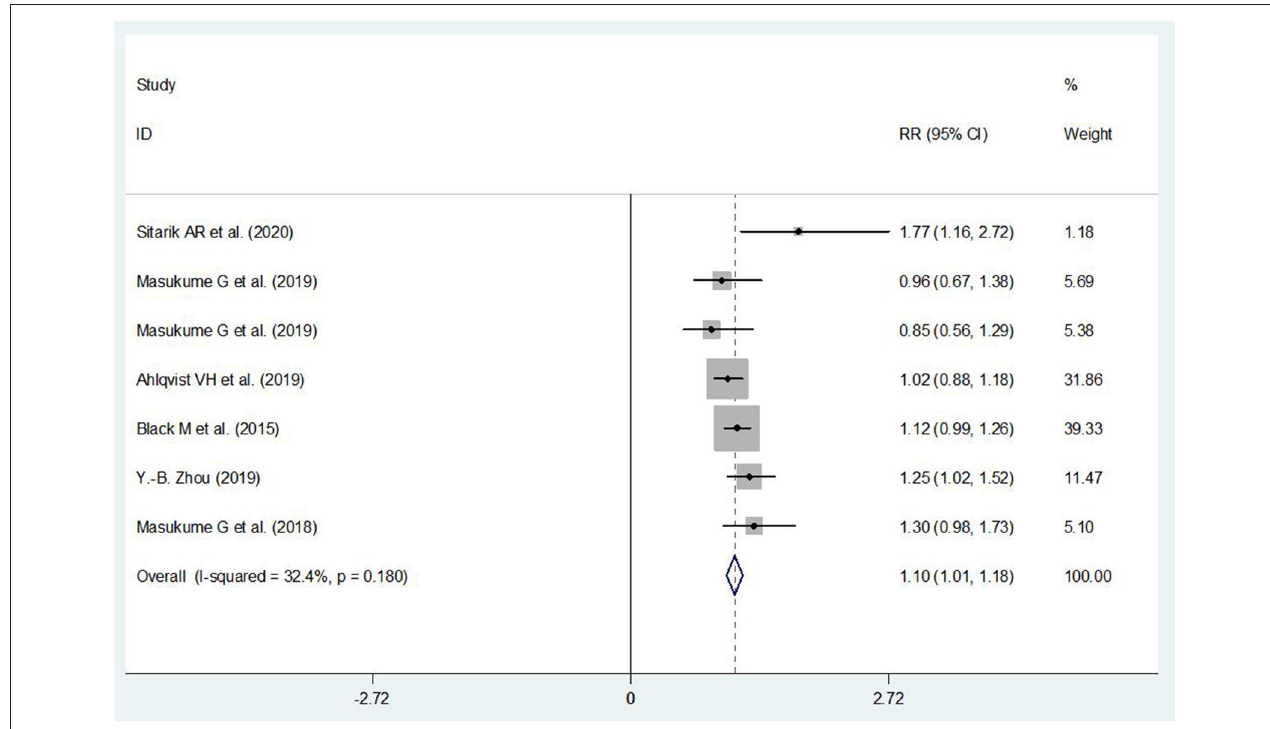
FIGURE 4 | The association between ECS and children’s